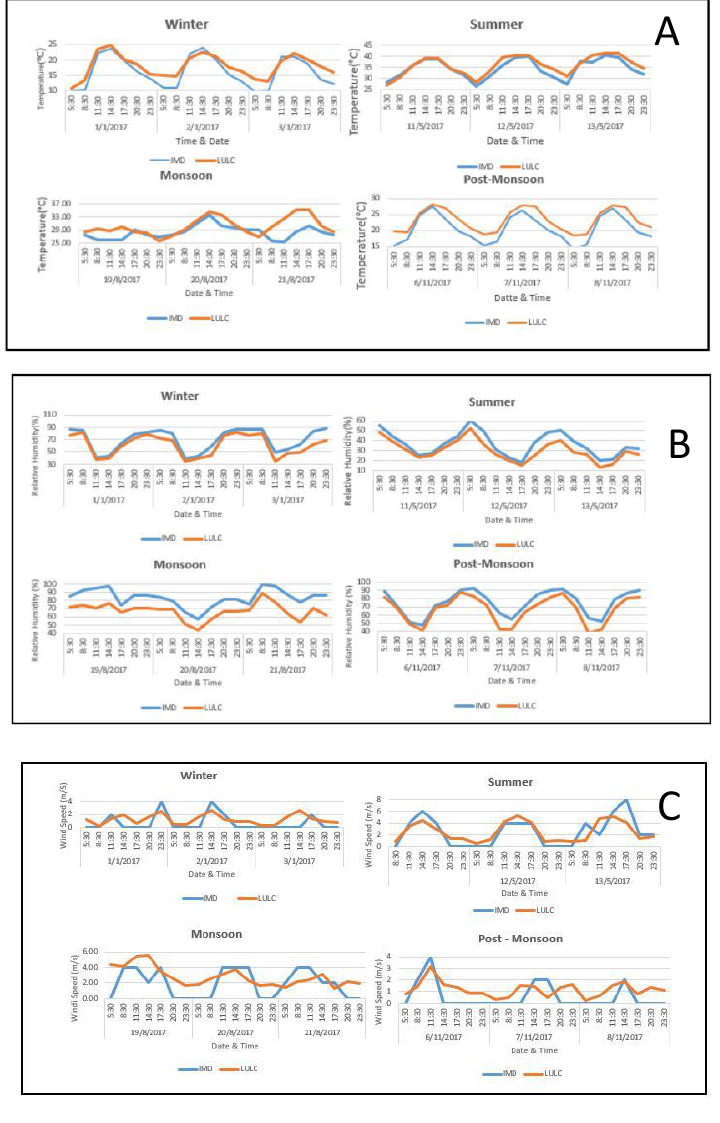
Figure 6. Comparison between observed and simulated A)